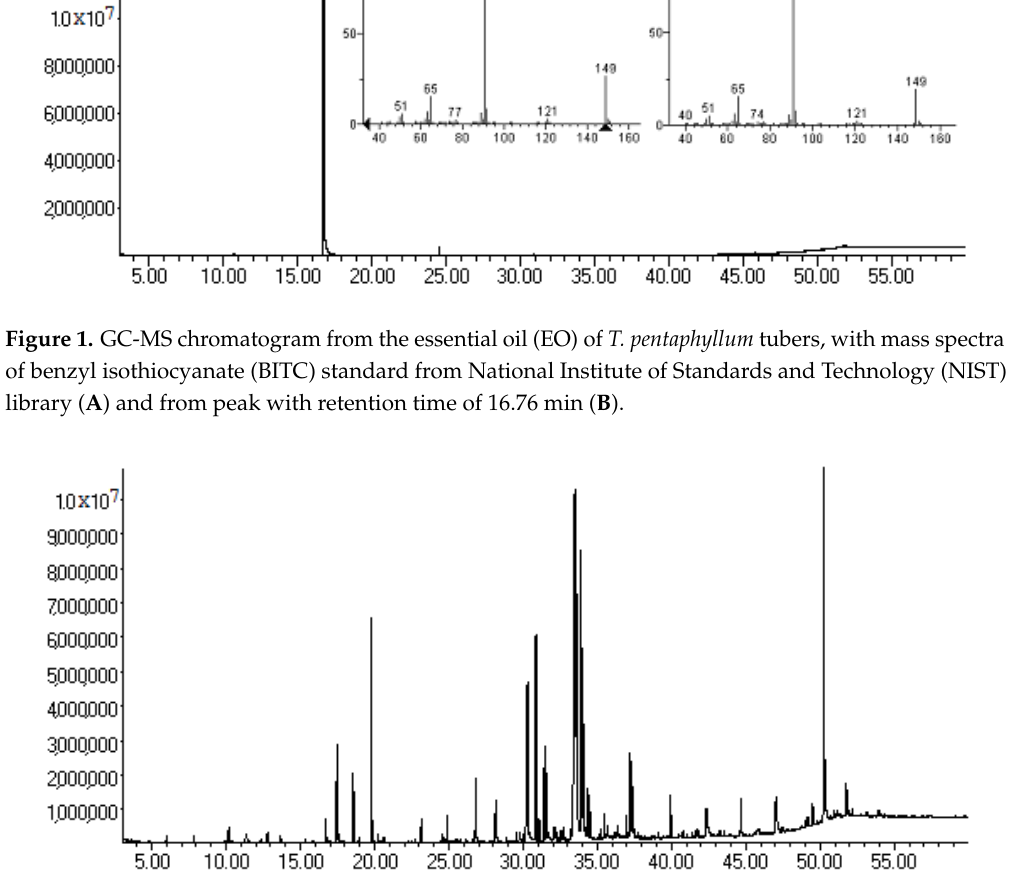
Figure 2. GC-MS chromatogram from the chloroform fraction of the CE from T. pentaphyllum